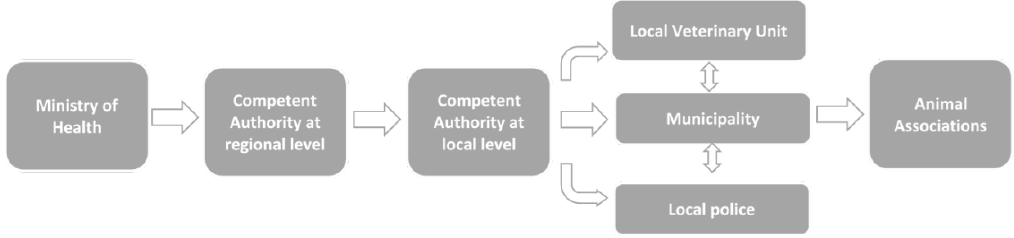
Figure 1. Flow chart to obtain information on TNR programmes implemented in Italy and on dogs involved in these programmes.